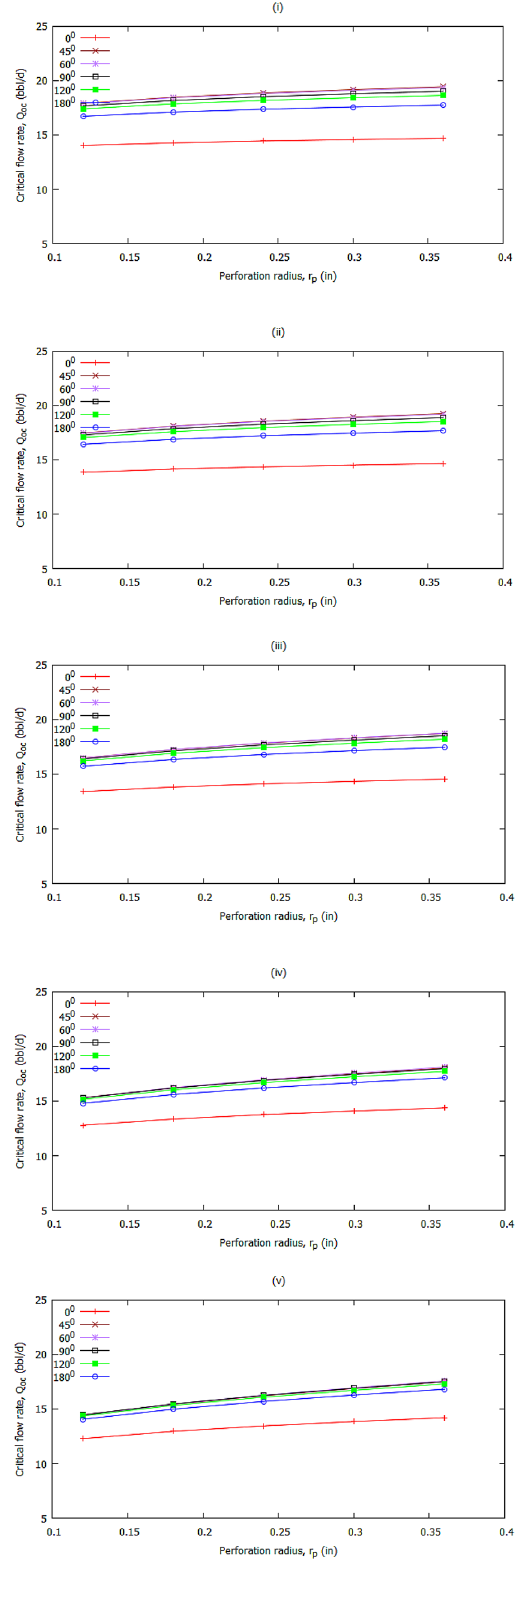
Fig. 5 Perforation length of 18 in and spacing between perforations on critical flow rate at different phasing angles and perforation radius. i Spacing between perforations at 1 in, ii Spacing between perfora- tions at 1.2 in, iii Spacing between perforations at 1.7 in, iv Spacing between perforations at 2.4 in and v Spacing between perforations at 3